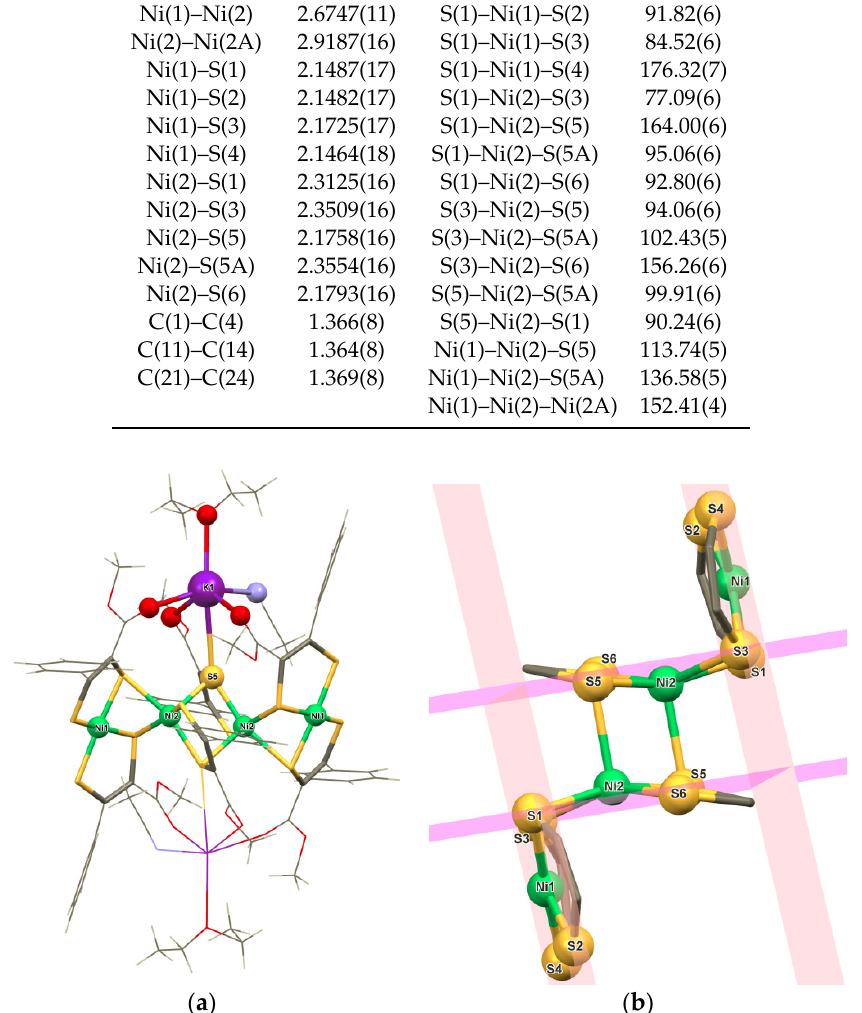
Figure 3. ( a ) The entire molecular structure of crystalline K 2 [Ni 4 (ecpdt) 6 ]·2CH 3 CN·2Et 2 O ( 4·2CH 3 CN·2Et 2 O ) highlighting all contacts around the three distinct metal centers (Ni1, Ni2, and K1); disordered minor occupancies not shown; carbon: gray, hydrogen: white, oxygen: red, sulfur: yellow, nickel: green, and potassium: purple. Selected bond lengths in Å: K1–O1: 2.591(5), K1–O3: 2.651(5), K1–O5: 2.676(5), K1–O7: 2.744(8), K1–S5: 3.378(2), and K1–N1: 2.831(8); ( b ) arrangement of nickel centers and coordinated dithiolene ligands (the ligand substituents are omitted for clarity); notably, the Ni2 centers are slightly dislocated above and below the S1, S3, S5, and S6 planes (darker pink), while Ni1 resides more firmly in the plane (brighter pink) of its four surrounding sulfur donor atoms (S1, S2, S3, and S4).